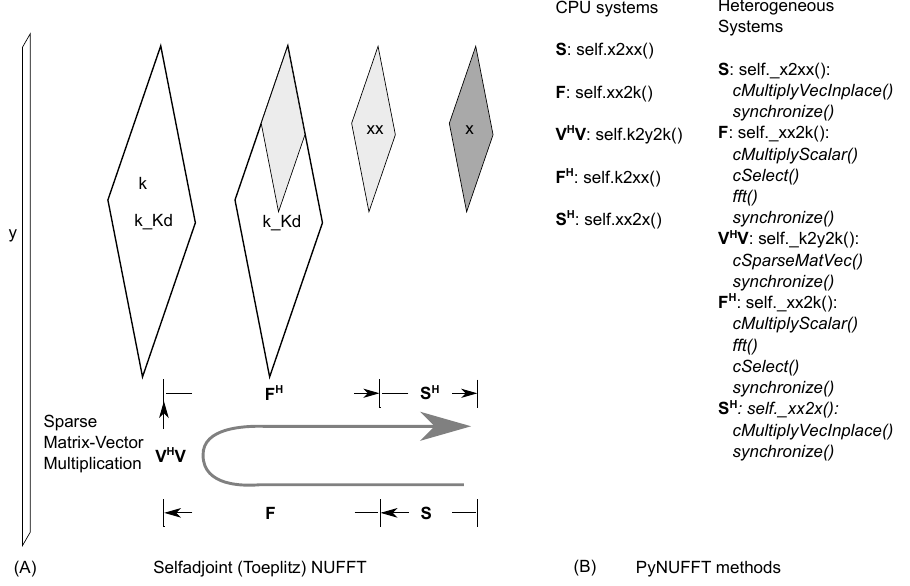
Figure 5. ( A ) The self-adjoint NUFFT (Toeplitz); ( B ) The methods are provided in PyNUFFT. The Toeplitz method precomputes the interpolation-gridding matrix ( V H V ), which can be accelerated on the CPU and GPU. See Table 1 for measured acceleration